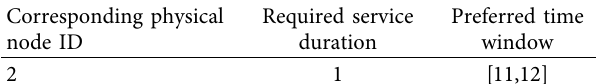
Table 8: Basic information on the pick-up request.